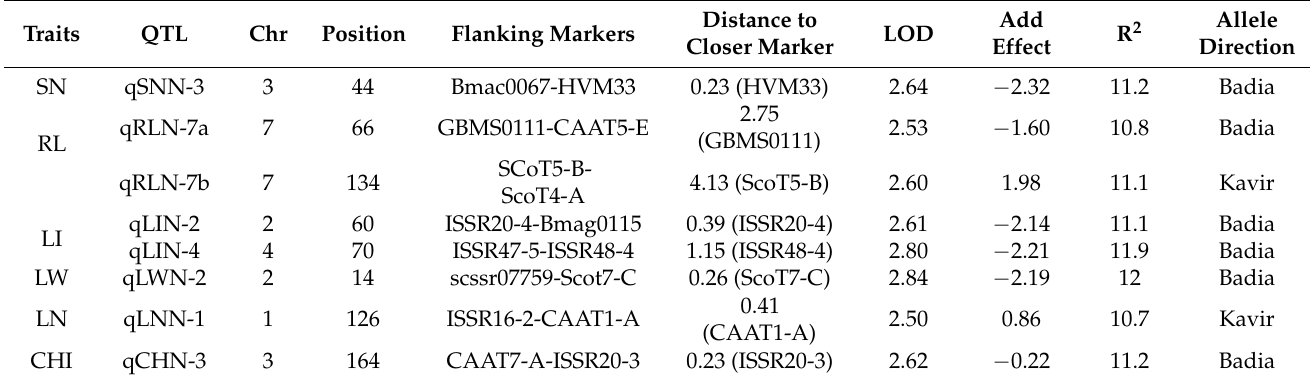
Table 8. QTLs controlling traits in barley under normal conditions in seedling in the RIL population caused by the Kavir and Badia